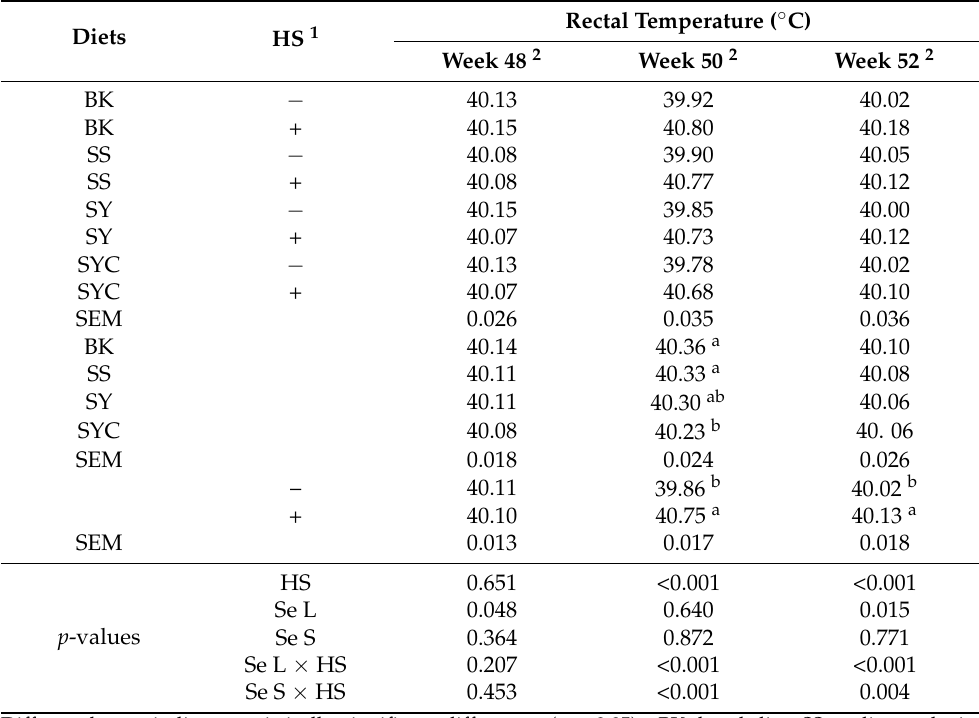
Table 2. Effects of different Se sources in diet on rectal temperature of laying